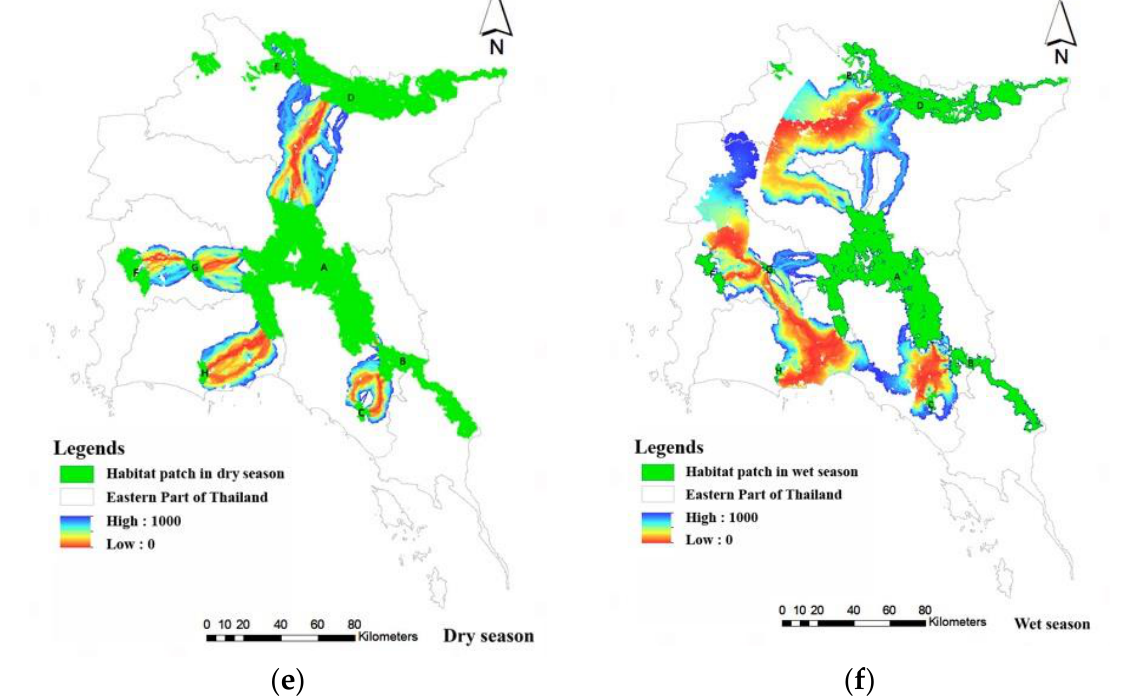
Figure 6. Habitat patches of wild elephants in ( a ) the dry season and ( b ) the wet season; least-cost path in maintaining a corridor within the entire habitat network of the eastern part of Thailand in ( c ) the dry season and ( d ) the wet season; the corridor identified according to least-cost area (low resistance is light pink color and high resistance is blue color) analysis in ( e ) the dry season and ( f ) the wet season in 2020.